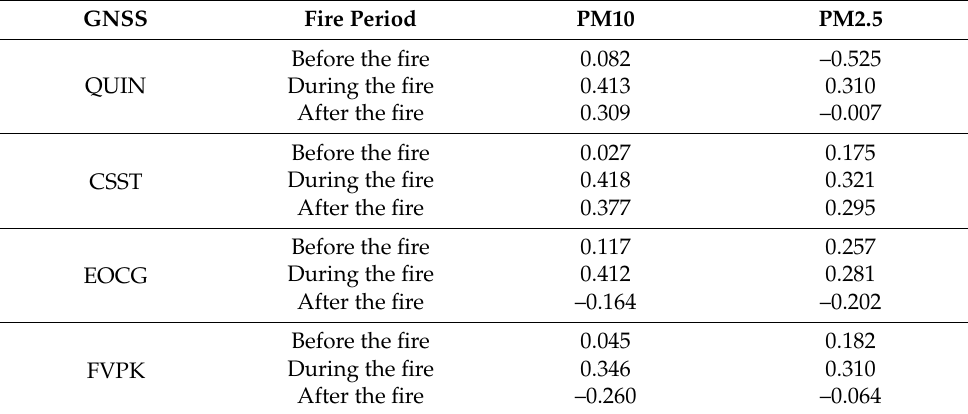
Table 8. The correlation analysis of ∆ PWV principle component ( ∆ PWV PC ). GNSS Fire